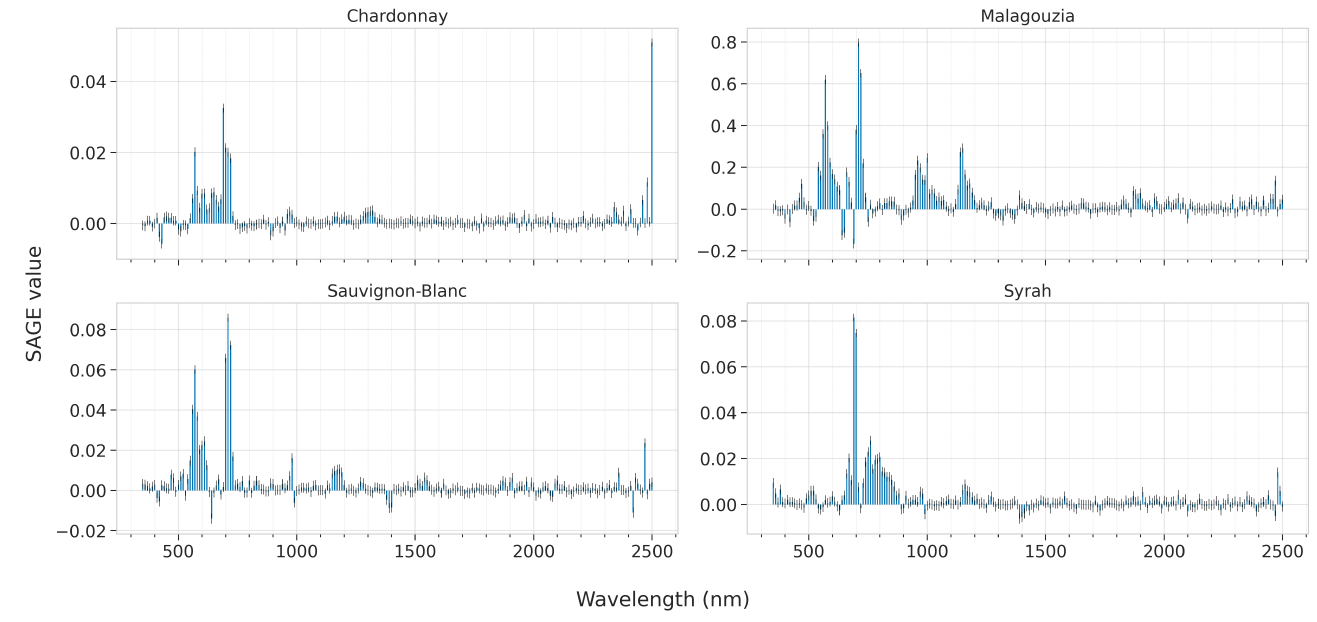
Figure 14. Mean feature importance according to SAGE values for the best SVR model across the five folds and for each of the four grape varieties; the higher the bar, the more informative the feature about the °Brix content.